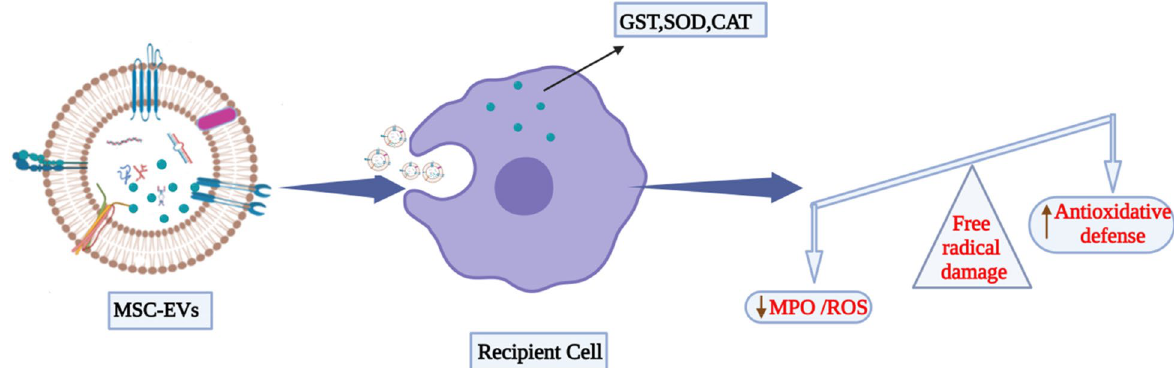
Fig. 6 MSC-EVs have the ability to deliver antioxidant enzymes like superoxide dismutase (SOD), glutathione S-transferase (GST) and catalase (CAT) directly into the target cells. These anti-oxidant enzymes effectively reduce oxidative stress and inflammation in